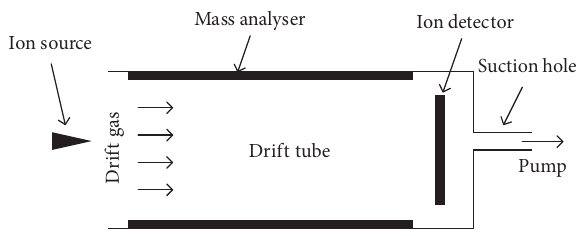
Figure 1: Schematic of the proposed low-vacuum mass analysis